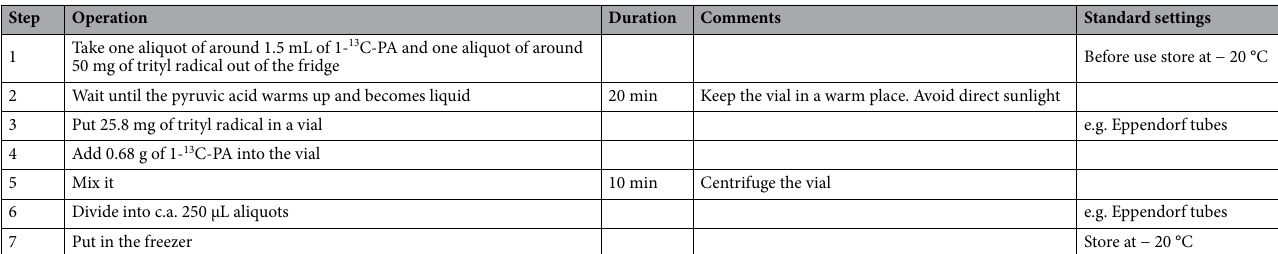
Table 4. Standard procedure to prepare pyruvate